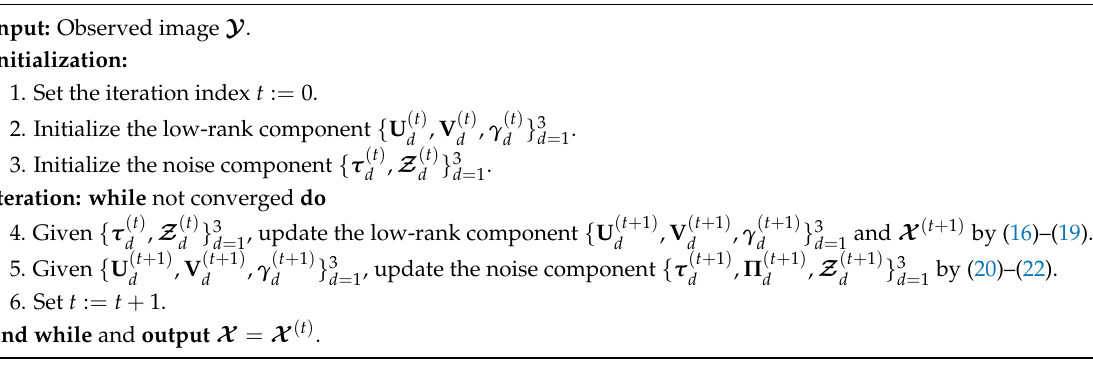
Algorithm 1. Variational Bayesian algorithm for